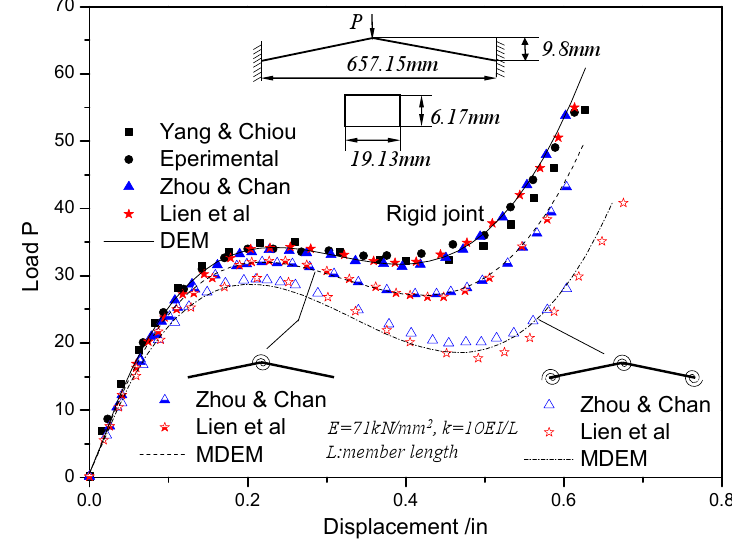
Figure 12. Displacement response of the Williams Toggle frame with linear semi-rigid connections and supports.